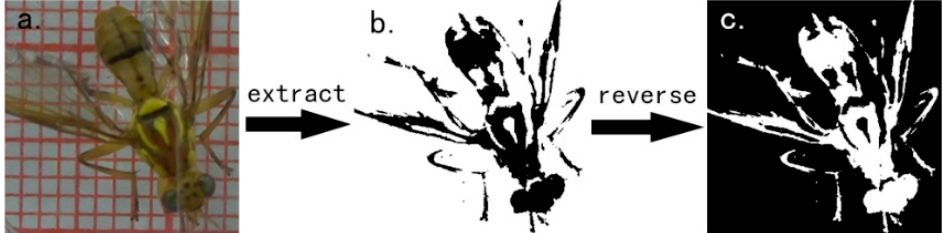
Figure 3. The extraction process of body part information of Bactrocera minax. ( a ) The original video frame contains the Bactrocera minax and the background which is RGB image; ( b ) Image P b only contains background, the gray value of the black region is 0, and the gray value of the white region is 255; ( c ) Image P b after